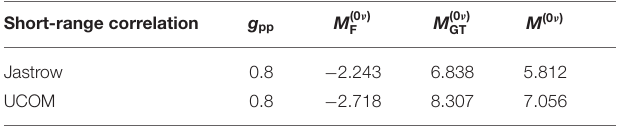
TABLE 4 | Nuclear matrix elements for 0 νβ + β + decay of 106 Cd corresponding to g A (0) = g eff A = 1.0 in the single-particle bases used in [14], corresponding to the “Adj.” basis of the present study. Short-range